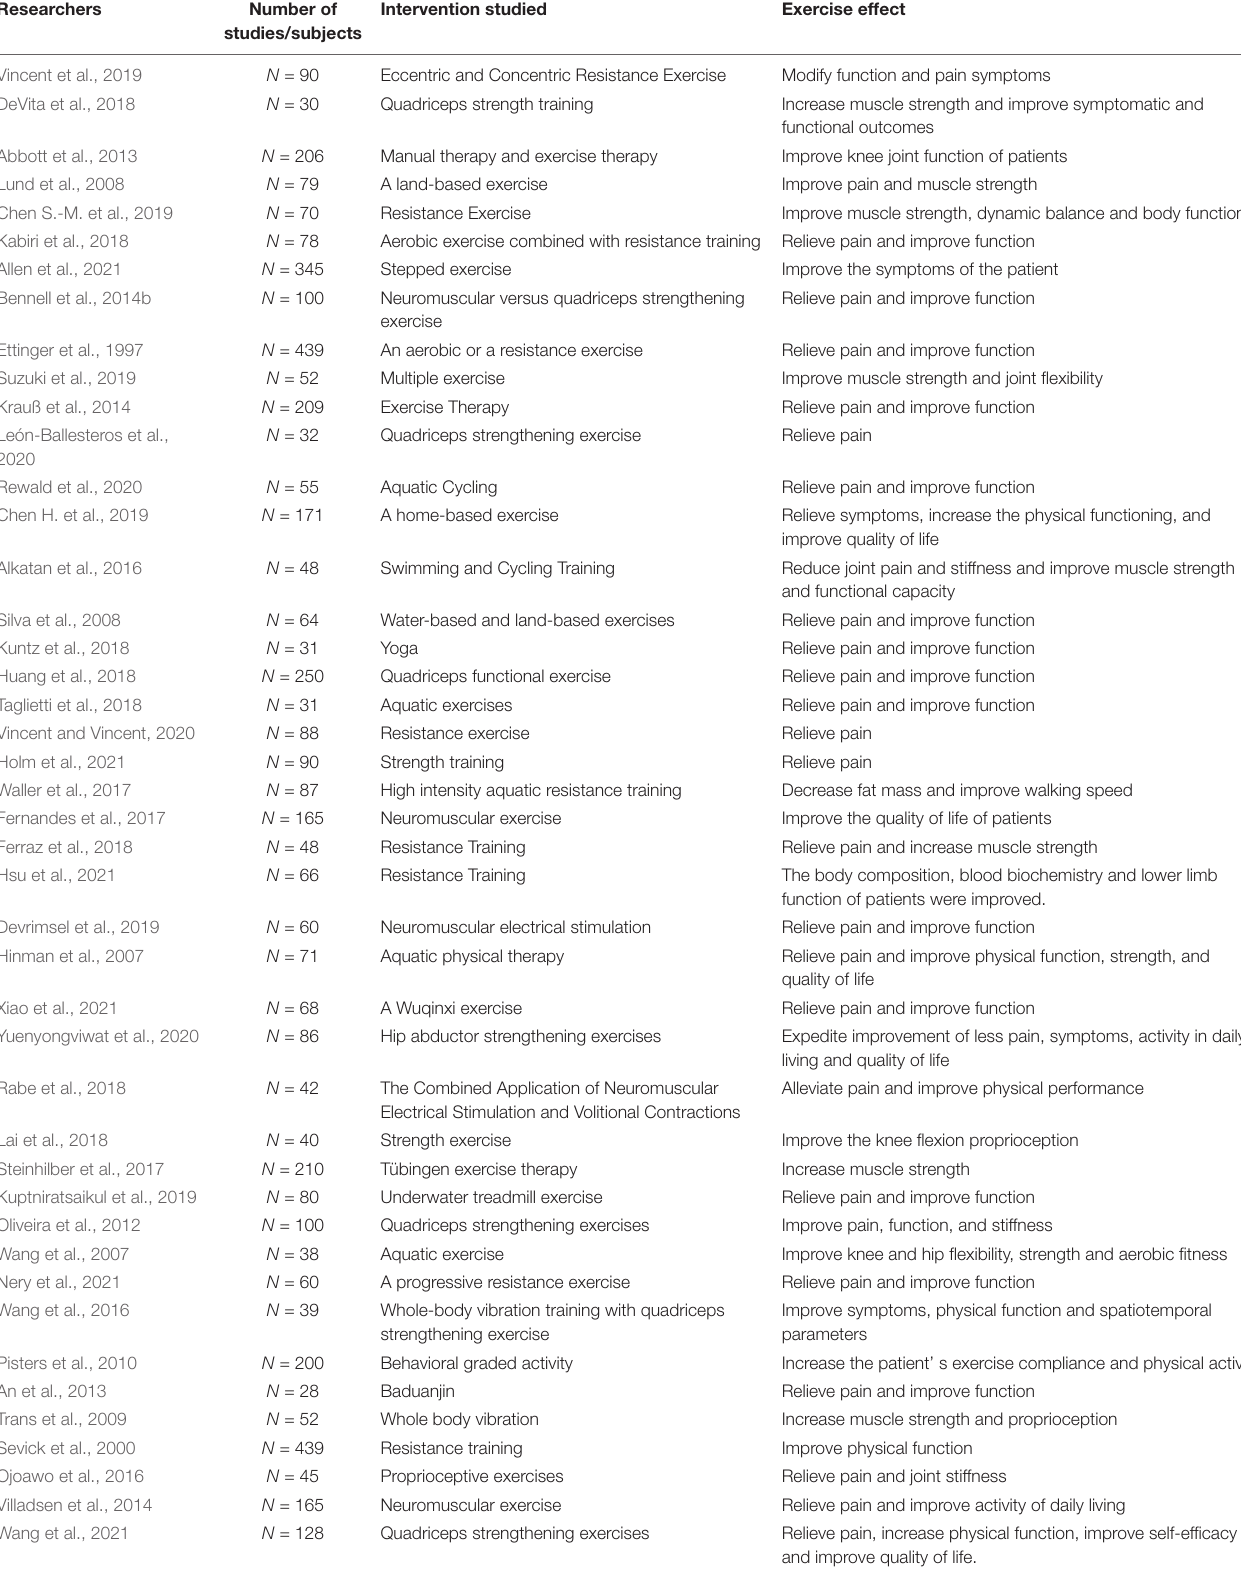
TABLE 2 | Different exercise types on human Osteoarthritis